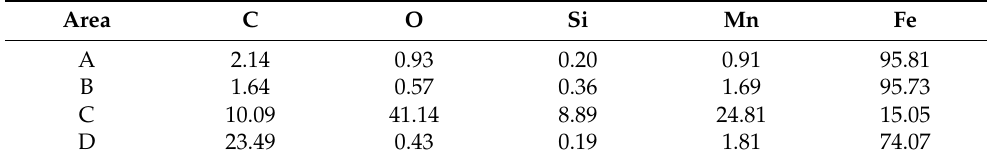
Table 3. EDS analysis results for each area in the cladding layer in specimen 1 (atomic fraction (%)).